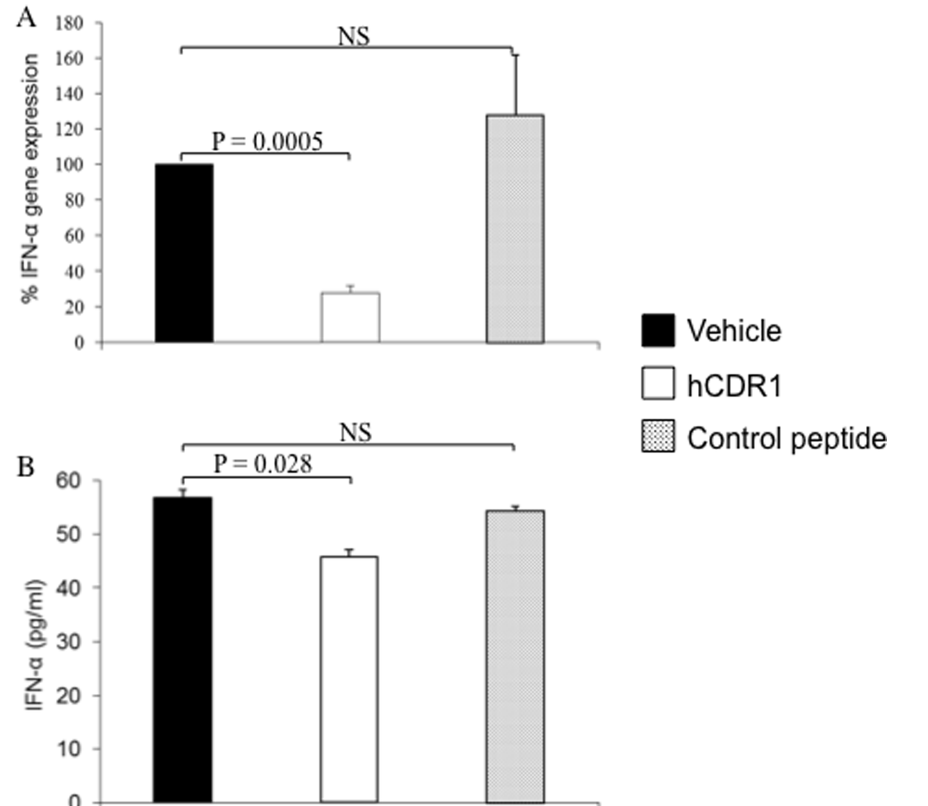
Figure 1. Treatment of SLE afflicted (NZBxNZW)F1 mice with hCDR1 results in the down regulation of IFN- a . (A) Mean percentage ( 6 SE) results of 4 independent experiments in which the mRNA expression of IFN- a was determined in pools of spleen derived cells of SLE afflicted mice (10–12 mice per group) treated with vehicle, hCDR1, or the control, scrambled, peptide. The levels of gene expression were determined by real- time RT-PCR and calculated relatively to levels in cells from vehicle-treated mice (considered as 100%). (B) Mean concentrations ( 6 SE) of IFN- a determined by ELISA in sera of the same groups of mice.